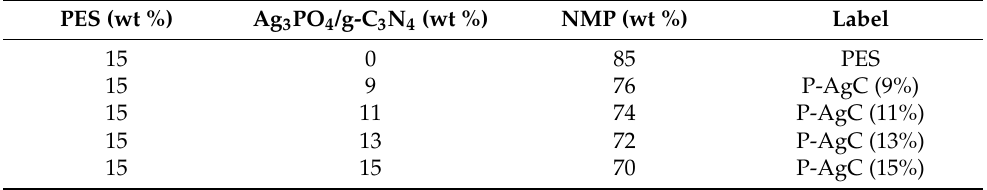
Table 1. The casting solution compositions for the preparation of P-Ag 3 PO 4 /g-C 3 N 4 film photocatalyst. PES (wt